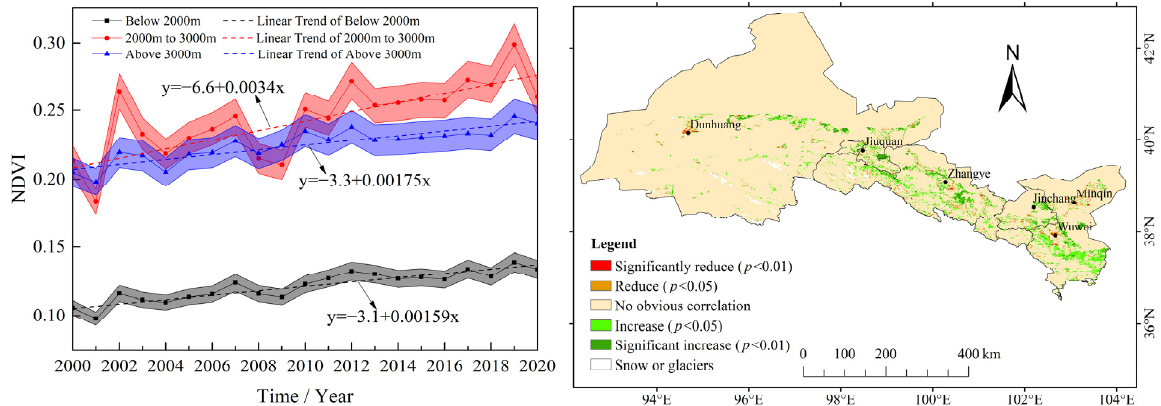
Figure 6. Trend of the NDVI in the Hexi Corridor during